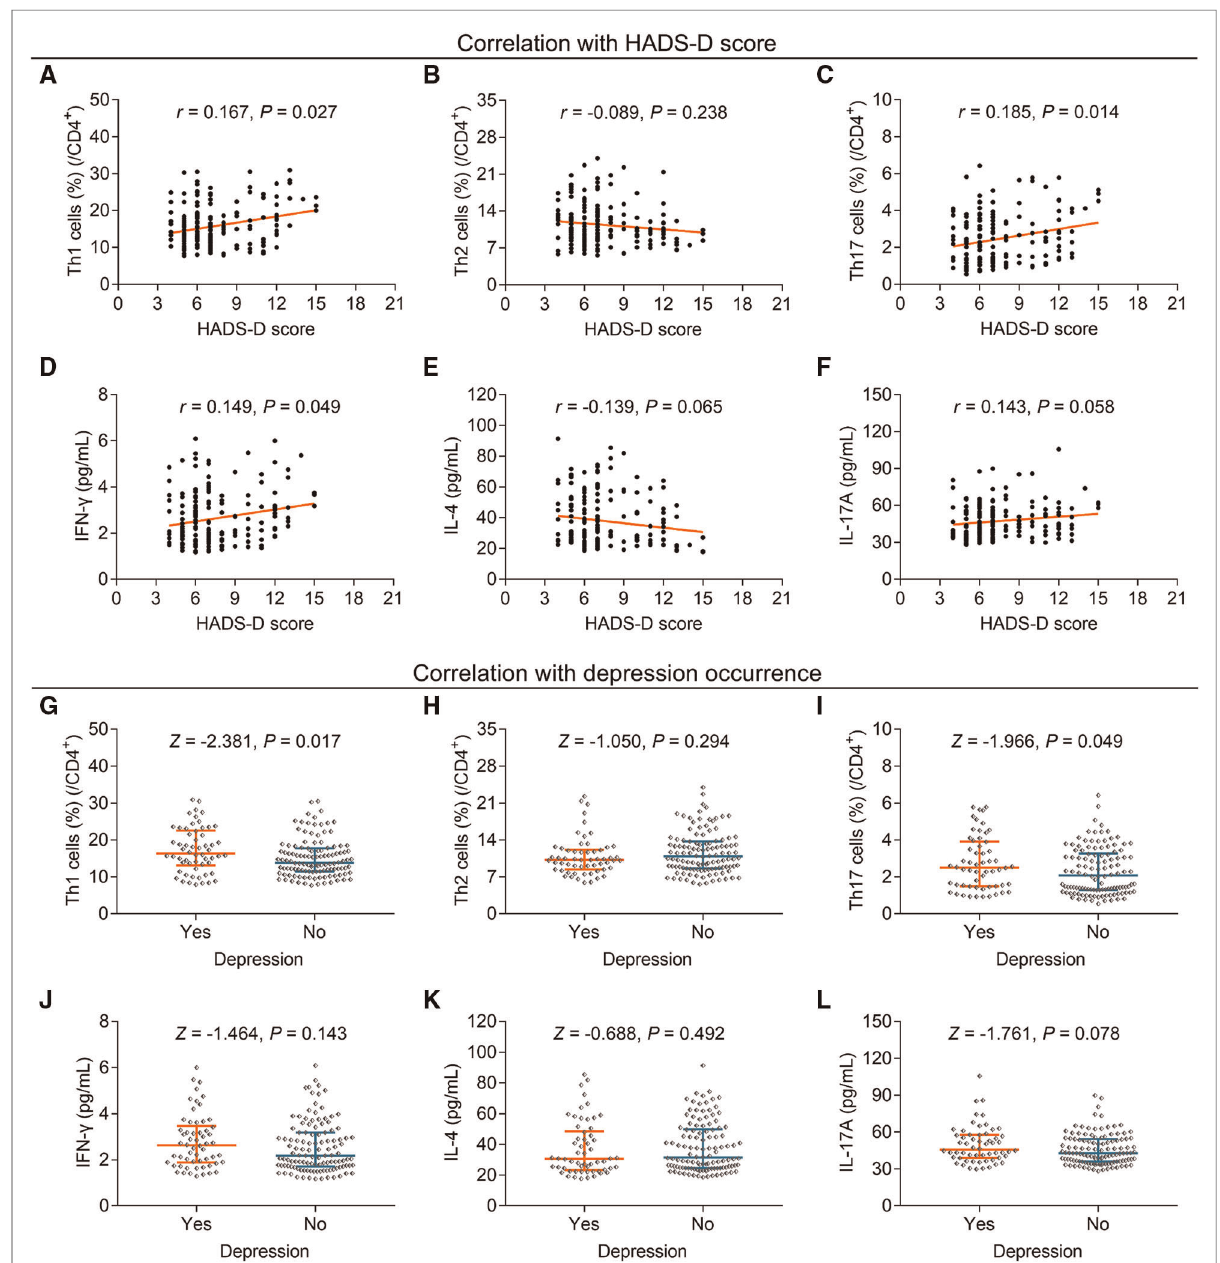
FIGURE 2 The association between Th1, Th2, and Th17 cells and depression in elderly gastric cancer patients. Association of Th1 ( A ), Th2 ( B ), Th17 cells ( C ), IFN- γ ( D ), IL-4 ( E ), and IL-17A ( F ) with HADS-D score; correlation of Th1 ( G ), Th2 ( H ), Th17 cells ( I ), IFN- γ ( J ), IL-4 ( K ), and IL-17A ( L ) with depression occurrence in elderly gastric cancer patients. Statistical methods: associations between continuous variables were analyzed using Spearman ’ s rank correlation test; the levels of Th cells and cytokines between patients with or without anxiety, depression, and cognitive impairment were determined using the Wilcoxon rank-sum